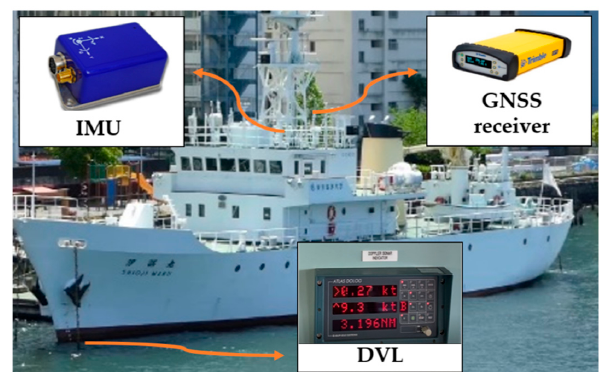
Sensors 2021 , 21 , x FOR PEER REVIEW Figure 6. Instrument setup. Figure 6. Instrument setup.